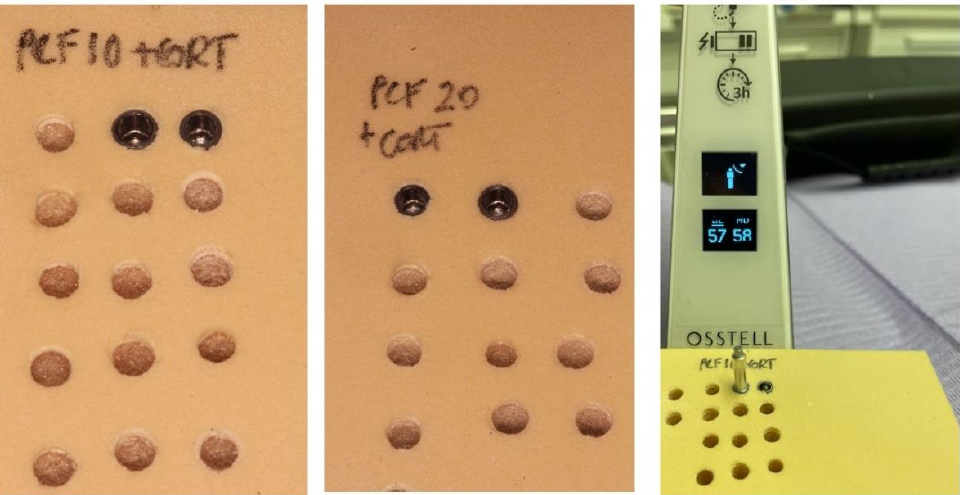
Figure 2. Details of the cylindrical and tapered implants positioned into polyurethane solid rigid blocks. Left: Implant devices inserted into 10 PCF + 1 mm cortical layer block. Centre: Implant devices inserted into 20 PCF + 1 mm cortical layer block. Right: Primary stability evaluated through the resonance frequency analysis device.